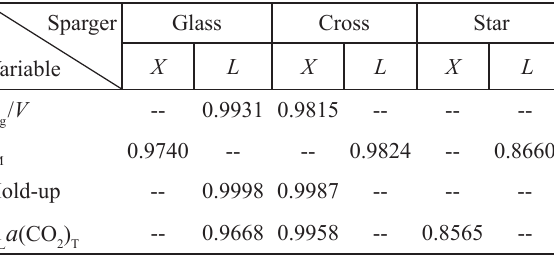
Table 4 – Pearson coefficient correlation, r 2 , calculated for each sparger tested, analyses between independent variables and biomass (X) and lipid (L) concentrations